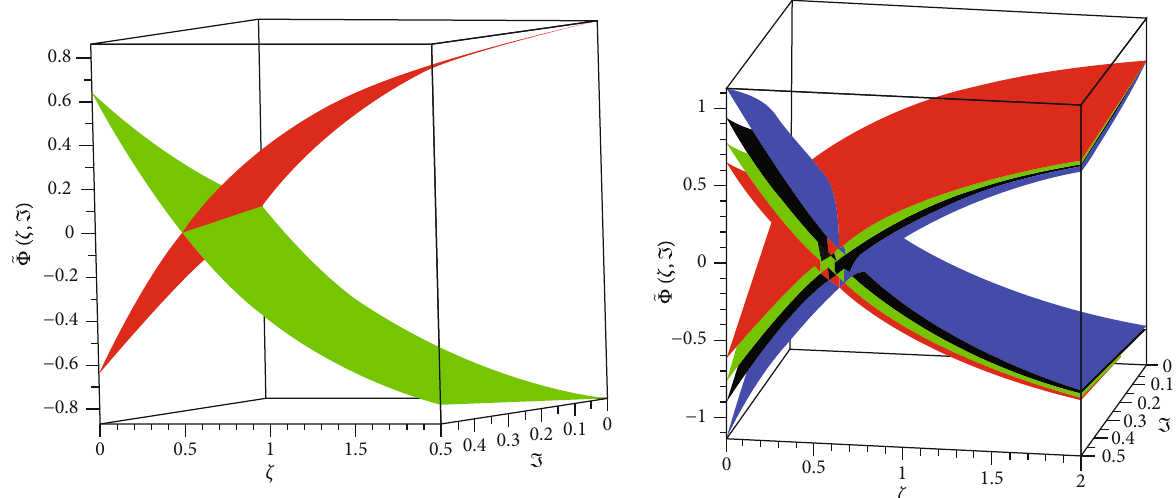
Figure 5: First graph shows the three-dimensional fuzzy lower and upper branch graph of analytical series solution and second graph the di ff erent fractional-order of ν